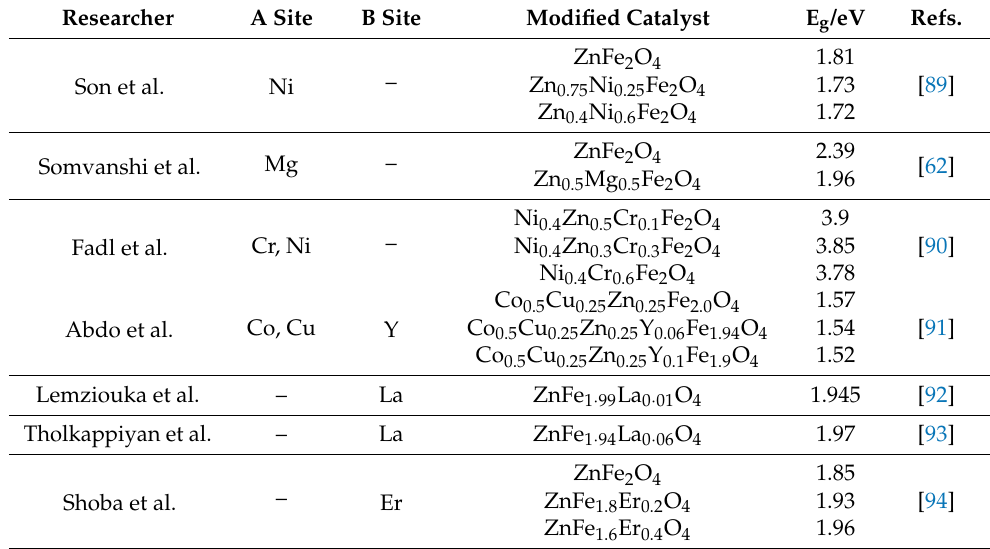
Table 3. The band gap change in the ZnFe 2 O 4 photocatalysts after doping at different